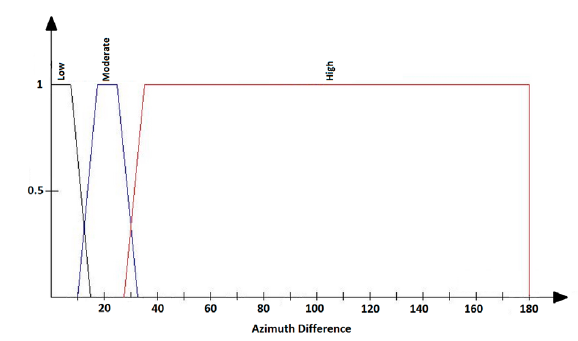
Fig. 11. Membership functions of azimuth difference